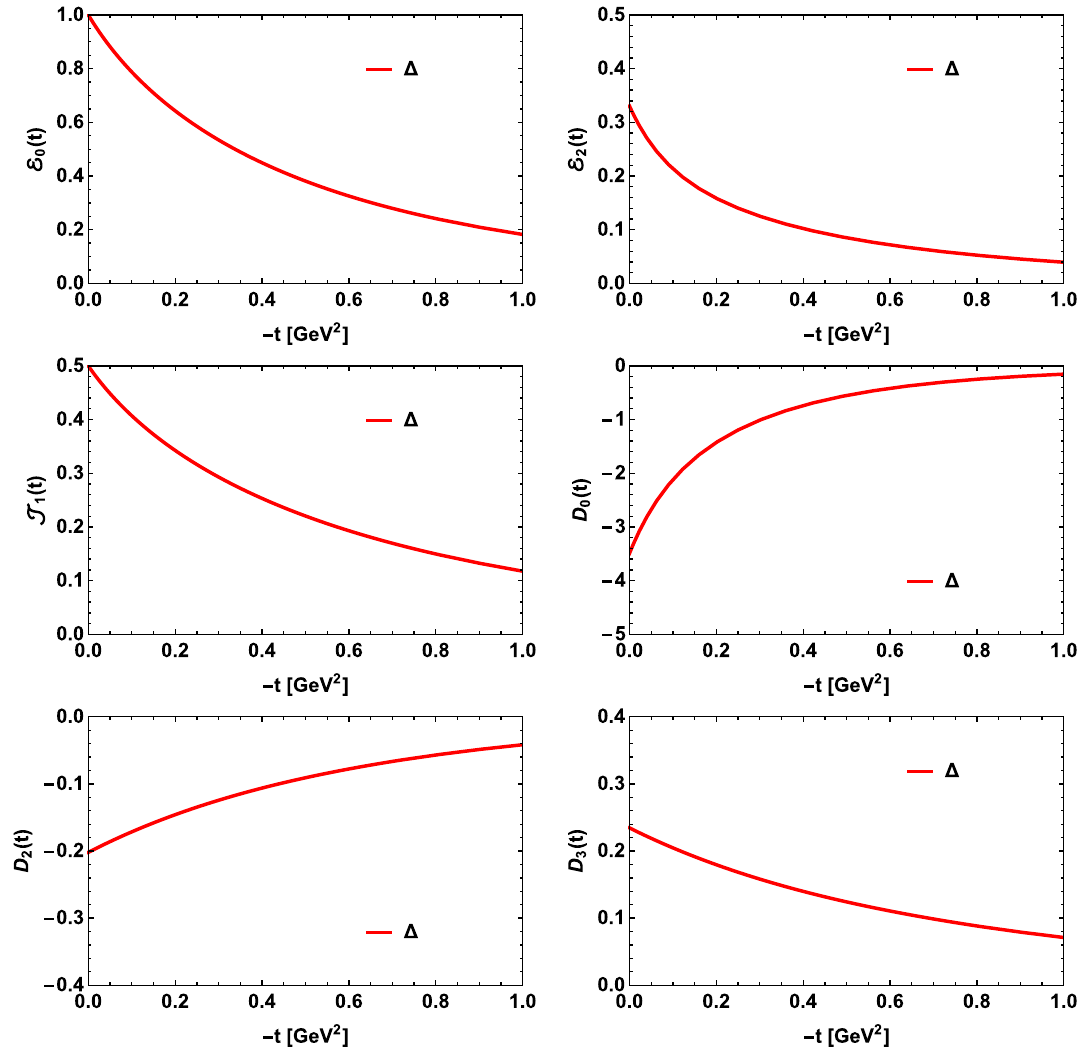
Fig. 6 Gravitational multipole form factors of the (cid:2) as functions of squared momentum transfer t